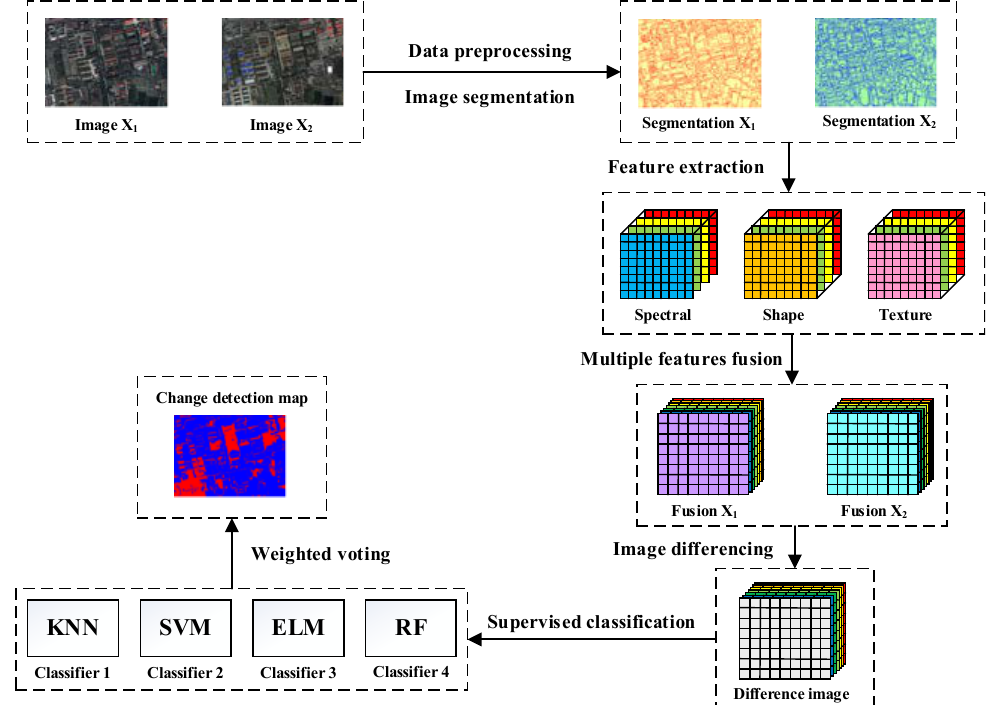
Figure 1. Framework of the proposed change detection approach using HR